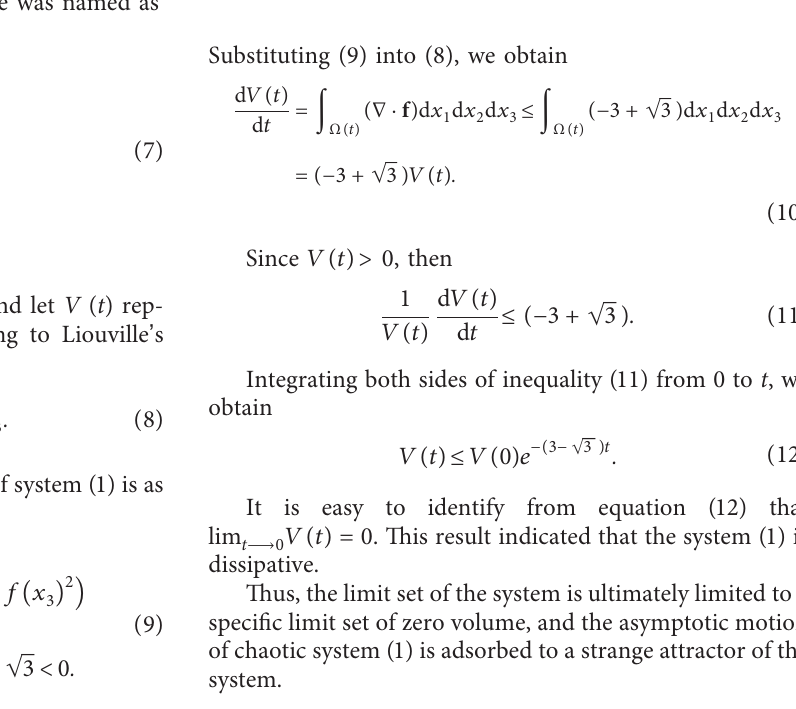
Figure 4: Two-dimensional projection of the chaotic neural net- work system on x 2 x 3 -coordinate